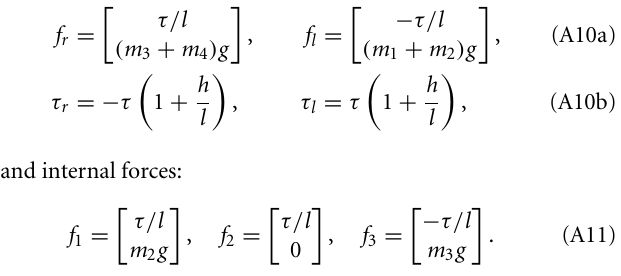
FIGUREA1 |The image shows the example of an articulated rigid body with two links in contact with the ground . Left figure. The system is composed of four rigid bodies.The centers of mass associated to the rigid bodies are indicated with a check board circle.Three rotational joints have associated torques τ 1 , τ 2 , and τ 3 . Central figure. The sketch shows the